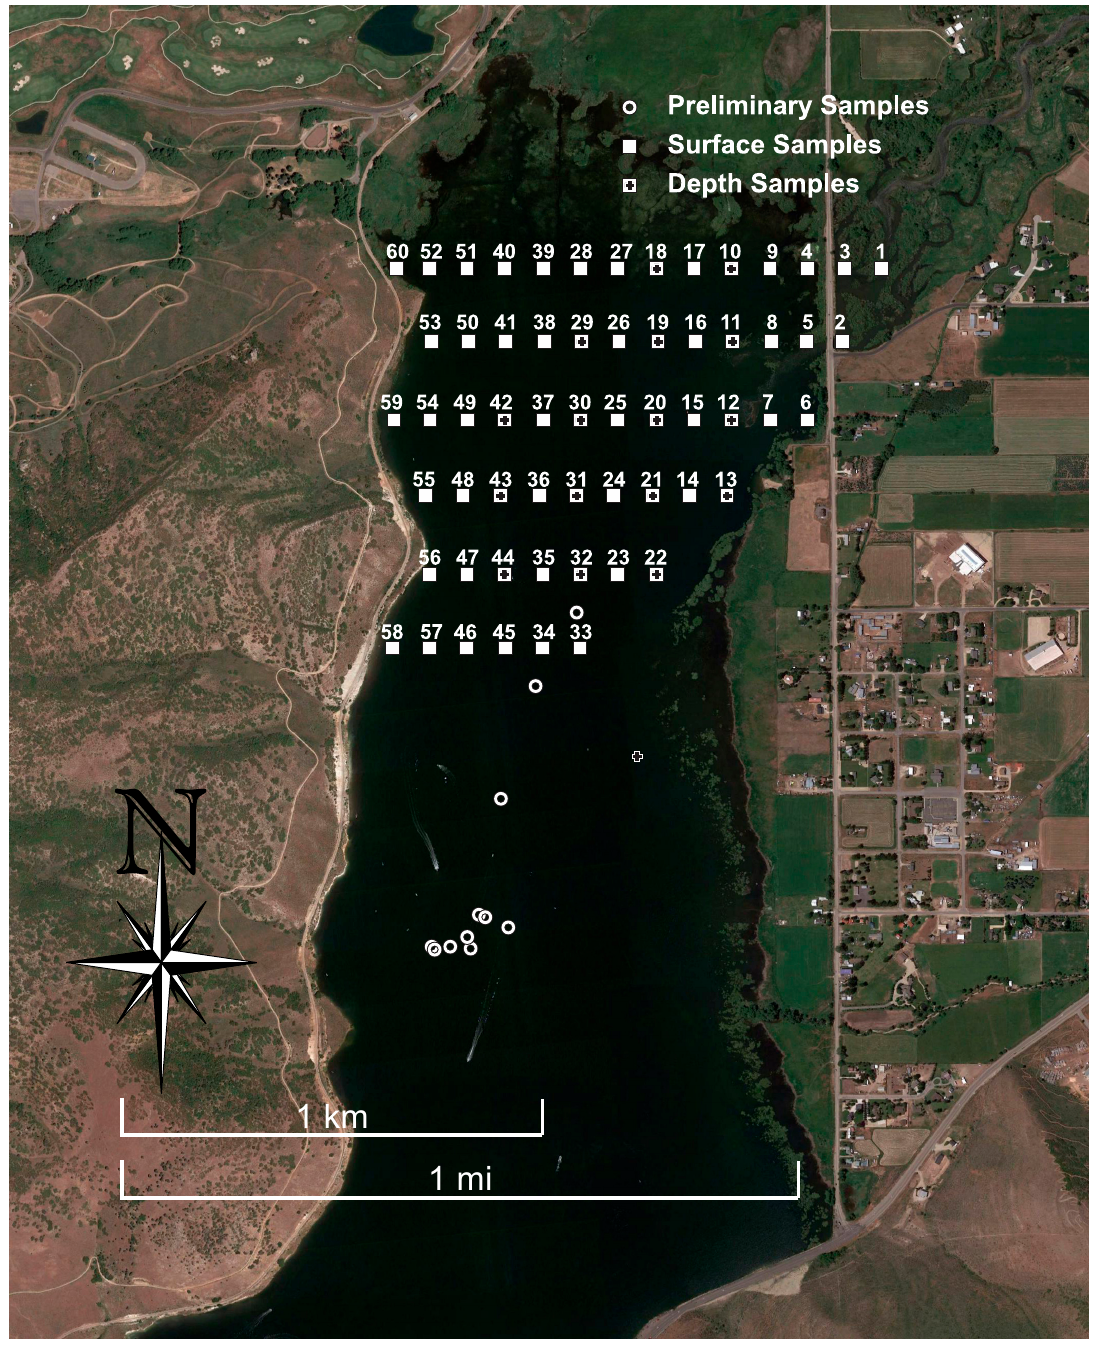
Figure 2. Sediment sample locations showing preliminary samples (circles), surface samples (squares), and samples at multiple depths (squares with cross).